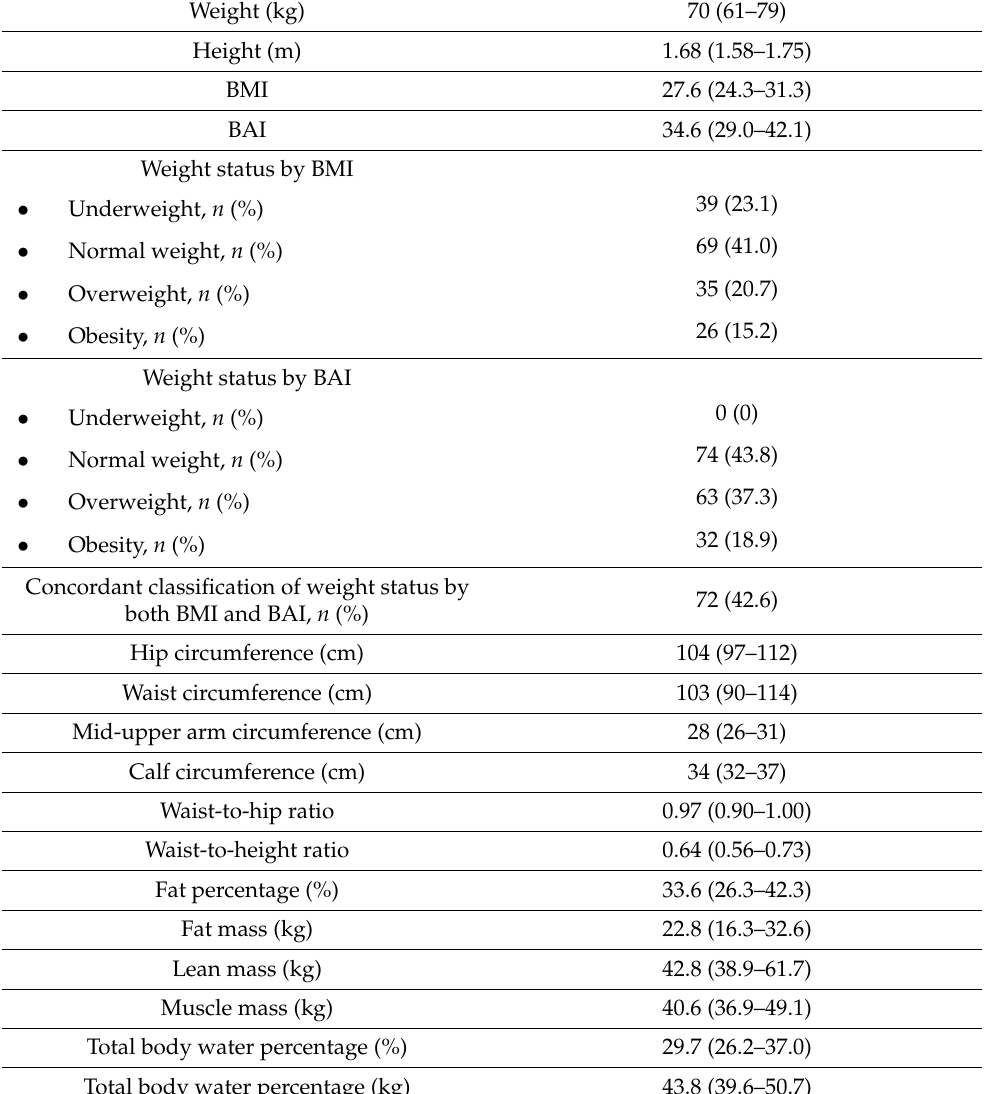
Table 3. Anthropometric and body composition